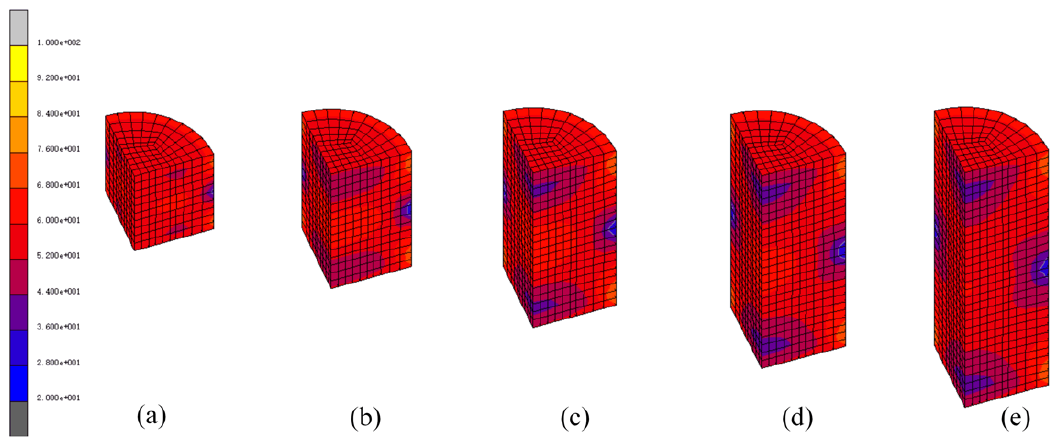
Figure 26. Relative density distributions in compact at the compaction pressure of 200 MPa for various height–diameter (H/D) ratios of ( a ) H/D = 0.7, ( b ) H/D = 1, ( c ) H/D = 1.4, ( d ) H/D = 1.8, and ( e ) H/D = 2.12.